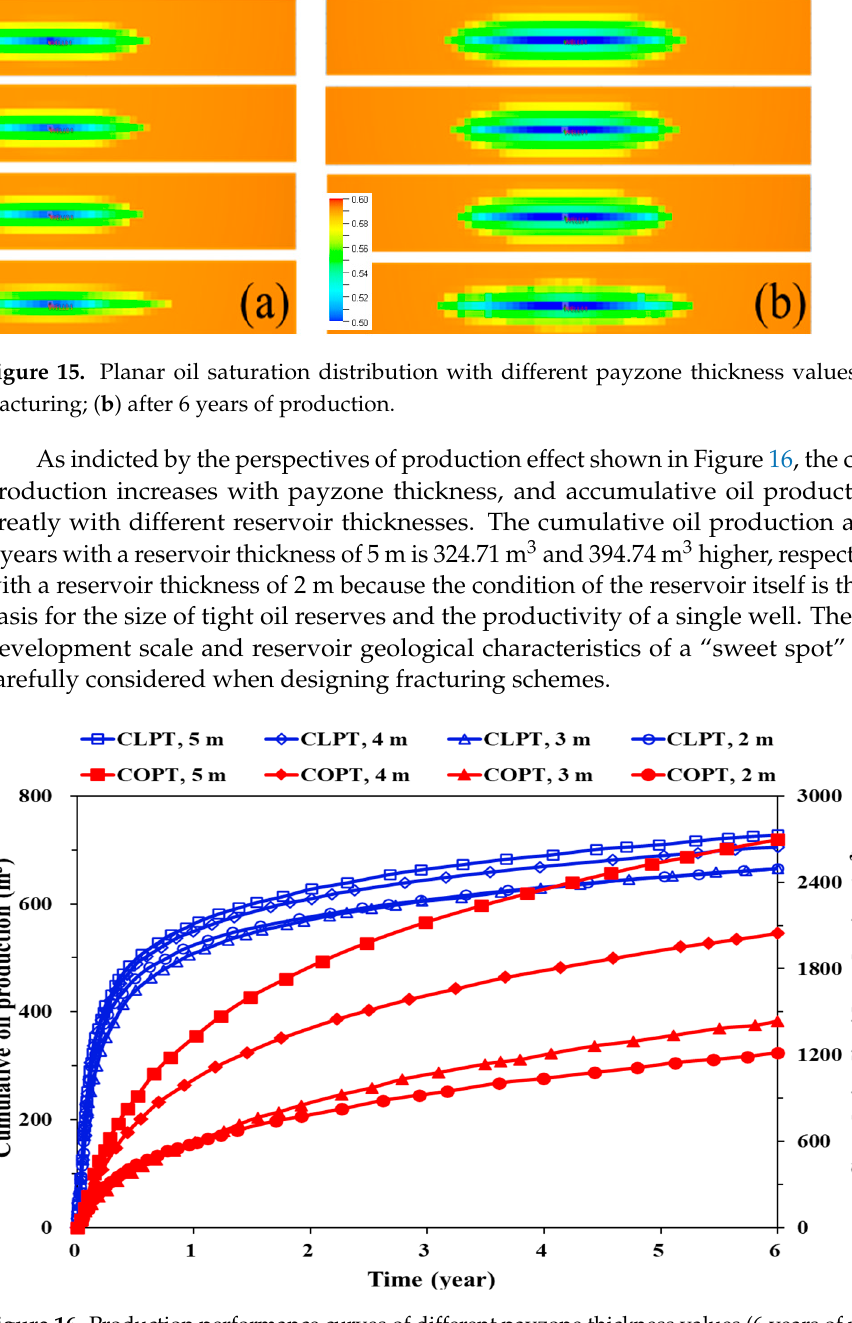
Figure 14. Planar fracture permeability distribution with different payzone thickness values. ( a ) Af- ter fracturing; ( b ) after 6 years of production.